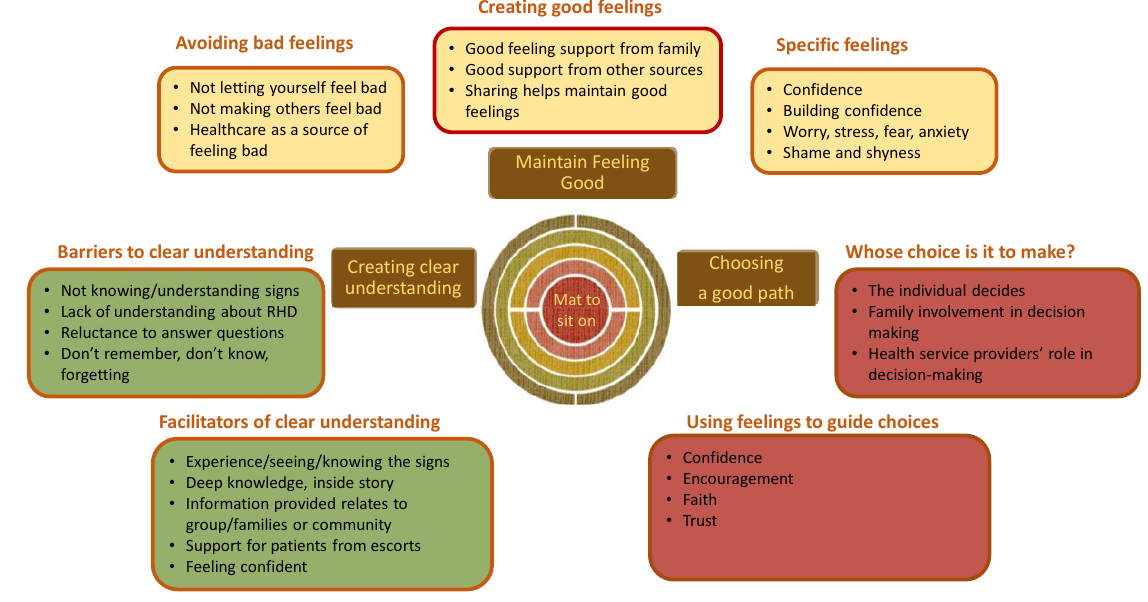
Figure 1. Thematic analysis summary: a mat for everyone to sit on.